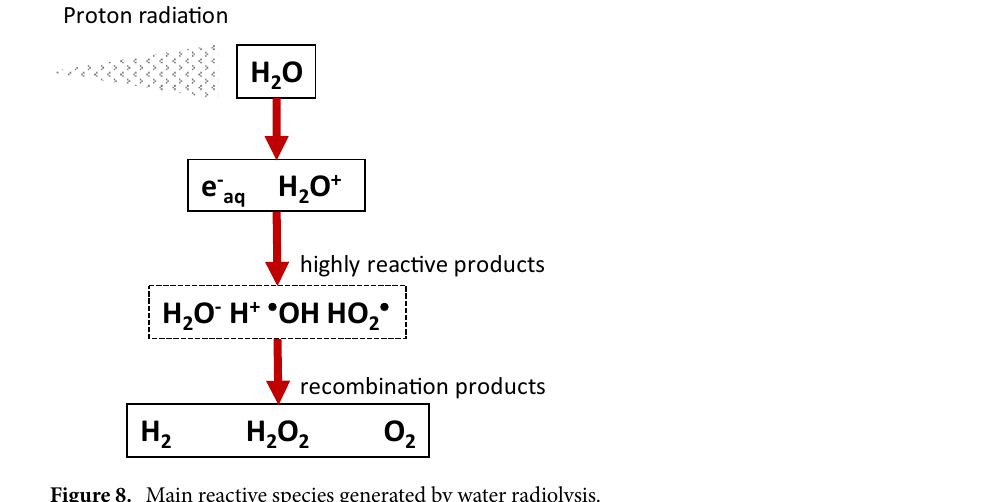
Figure 8. Main reactive species generated by water